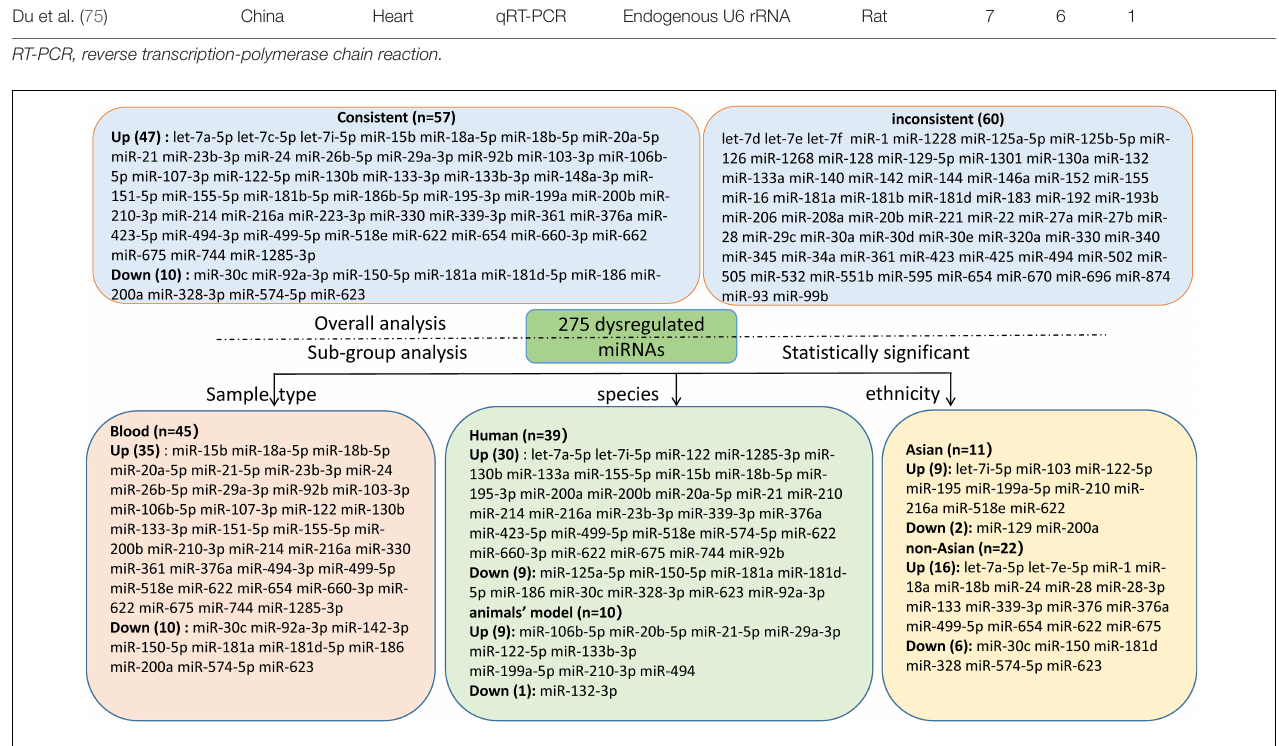
FIGURE 2 | The flow diagram of miRNA categories in this systematic review. miR,